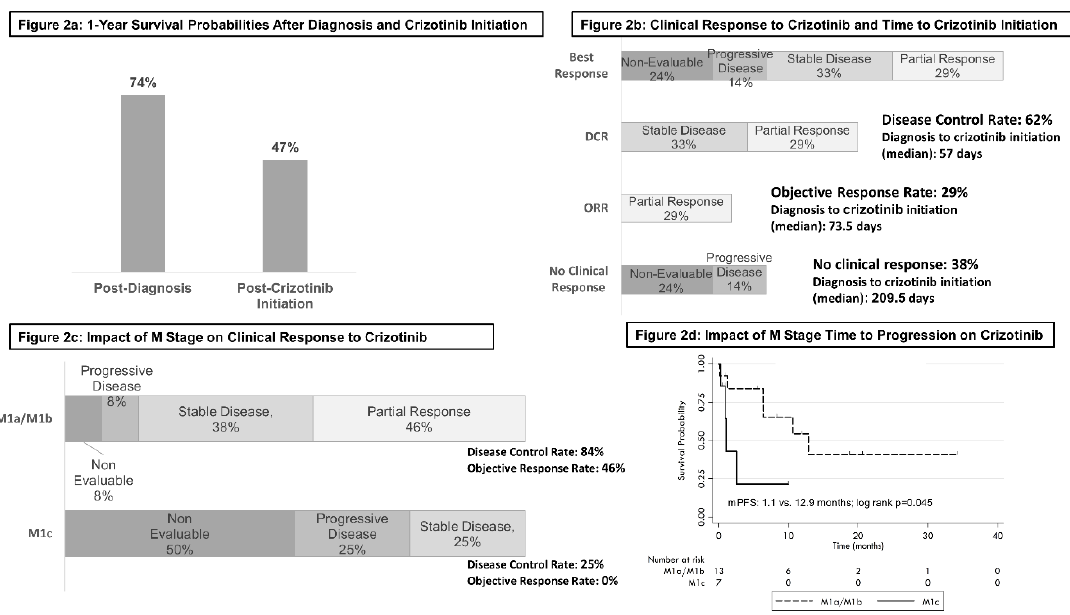
Figure 2. Clinical response to crizotinib: one-year survival ( a ); clinical response to crizotinib and time to crizotinib initiation ( b ); impact of M-stage on clinical response to crizotinib ( c ); impact of M-stage to time to progression on crizotinib ( d ).